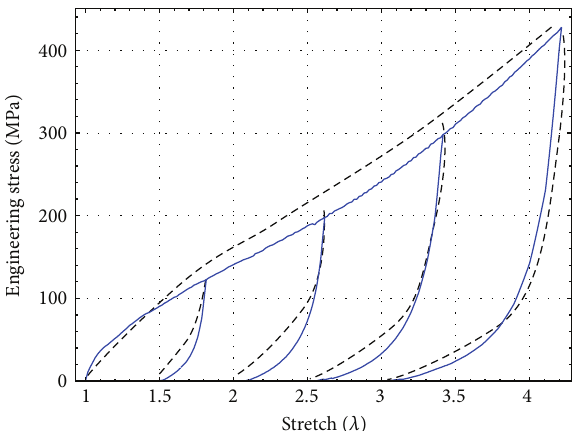
Figure 3: Engineering stress-stretch data for Monosyn sutures com- pared with theoretical predictions of the nonmonotonous amended average-stretch, full-network model for which 𝜇 = 92 MPa, 𝑁 = 20 , 𝑏 = 0.85 , and 𝐶 = 0.0045 MPa. The dashed black lines represent theoretical predictions, and the blue solid lines describe experimental